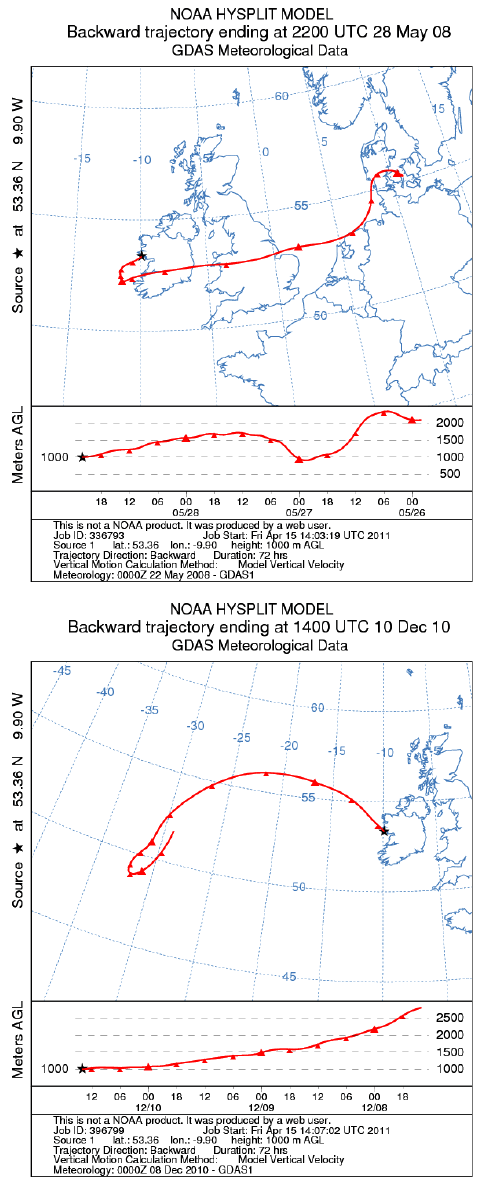
Fig. 1. 72-h backward trajectories (BT) calculated by NOAA HYS- PLIT model and based on GDAS Meteorological 1000-m BT on 28 May 2008 (left) and 10 December 2010